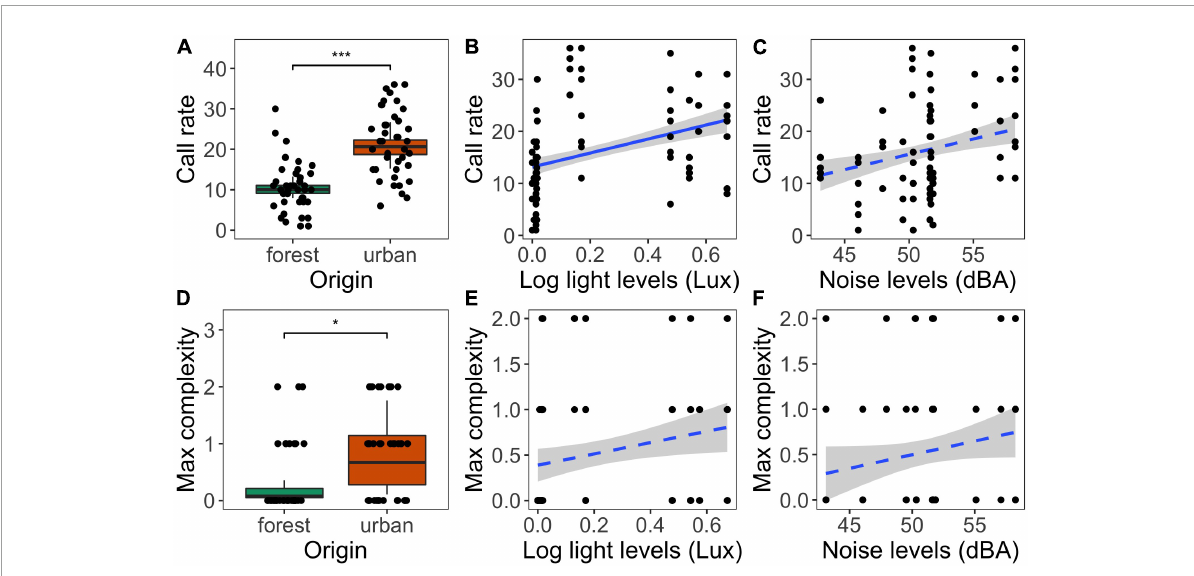
FIGURE2 Associations between calling behavior (call rate and maximum call complexity) and origin (A,D) , and local light (B,E) and noise levels (C,F) . Significant differences between urban and forest sites are indicated with an asterisk (* < 0.05, *** < 0.001). Solid and dashed regression lines (with 95% CI) indicate significant and non-significant relations, respectively. Boxplots and regression lines are based on model predictions (excluding the interaction between light and noise in case that was not statistically significant), data points shown are raw data. See text and Supplementary Table 1 for